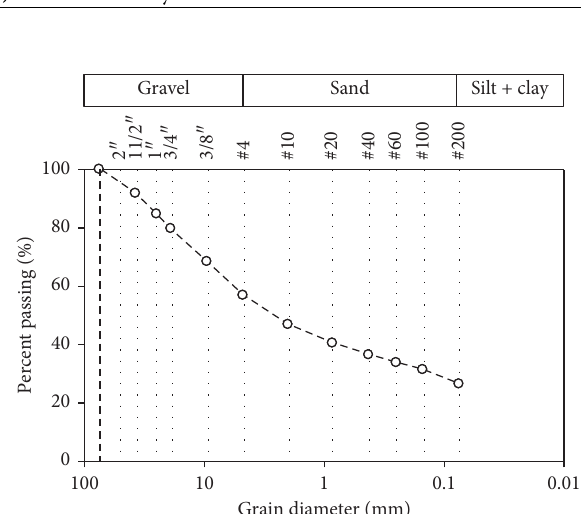
Figure 1: Hydrated class C fly ash (C-stone) grain-size distribution curve.